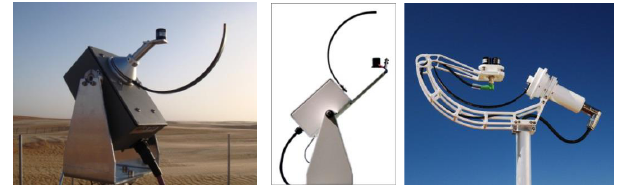
Figure 1. Rotating shadowband irradiometers. Left: RSR2 (irradi- ance Inc.), center: RSP4G (Reichert GmbH), right: Twin-RSI (CSP Services GmbH) (Wilbert et al.,